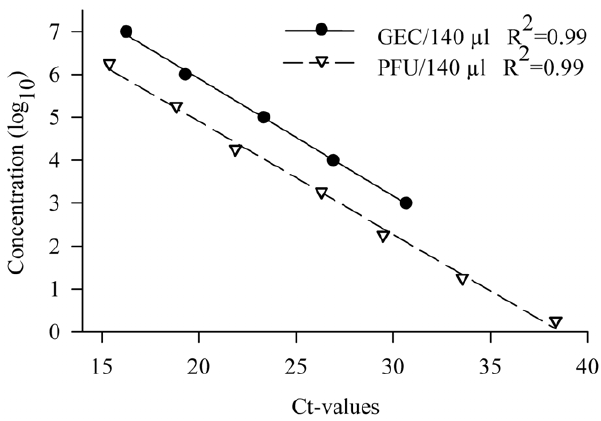
Figure 1. Regression analysis for the calibration of the number of IAV matrix gene copies (circles) and plaque forming units (triangles). The standard curve was generated using a log 10 dilution series of quantified RNA runoff transcripts or known concentrations of LPAI H5N9 stock virus.